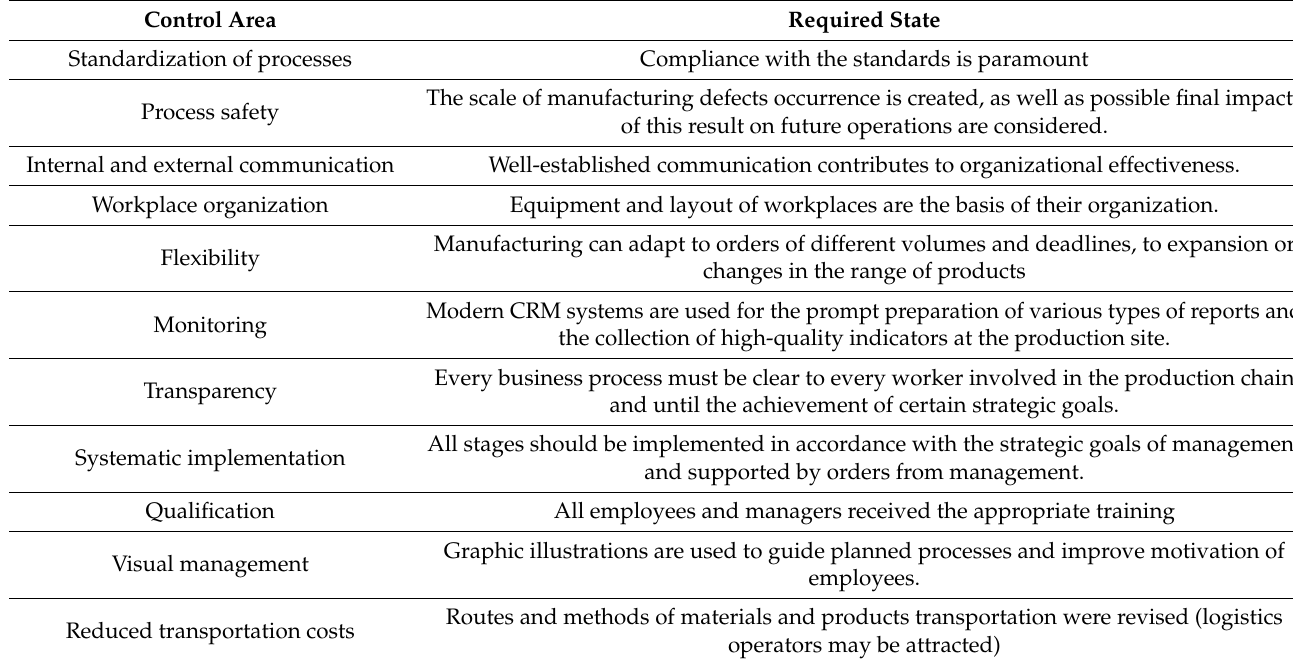
Table 1. Analysis technology